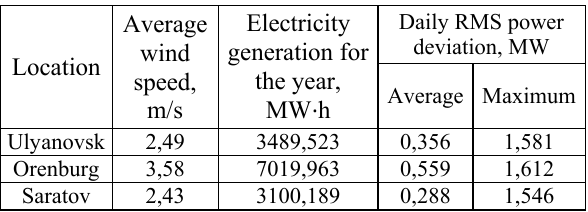
Table 1. Results of wind power variability assessment